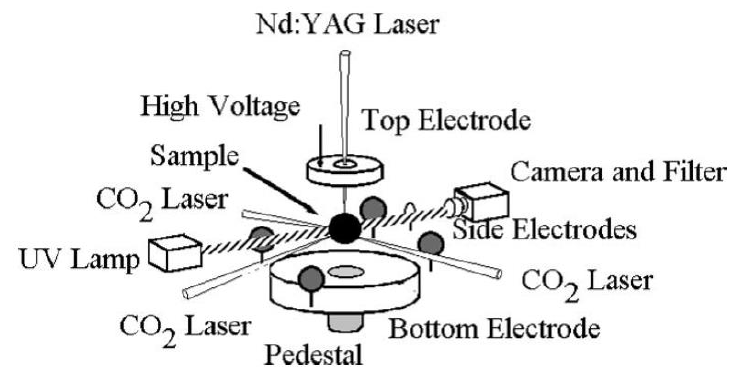
Figure 3. Isometric view of the levitation furnace, highlighting the flattened tetrahedral laser heating configuration [19].